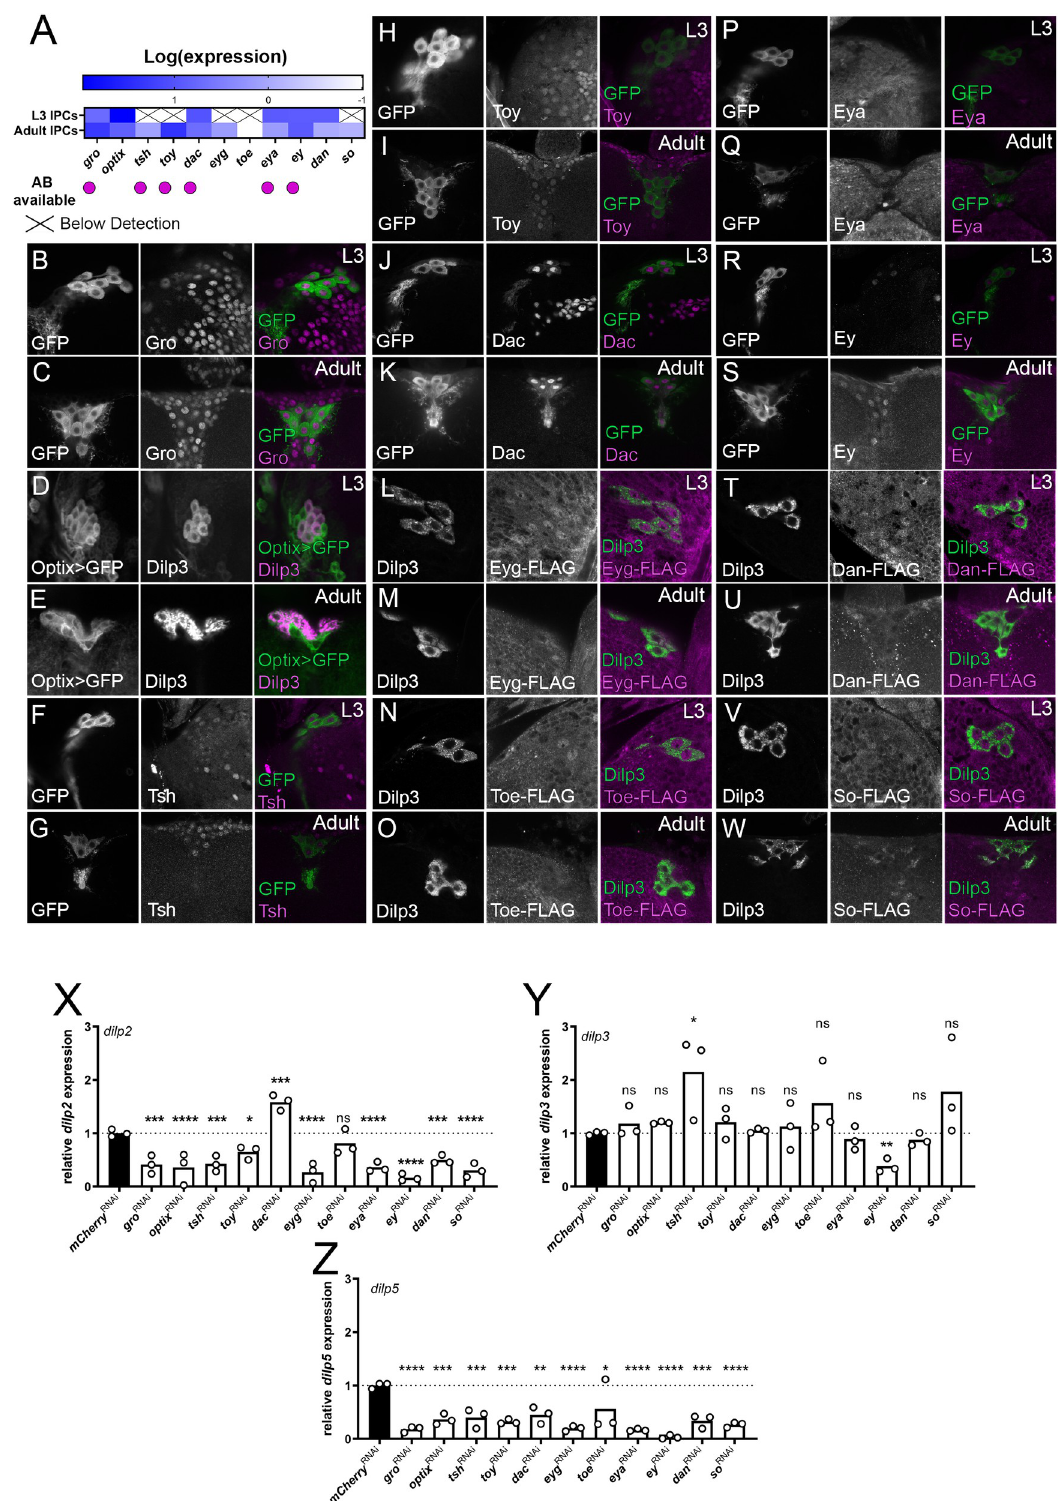
Fig 7. Most RDGN transcription factors are expressed in the IPCs and are required for normal adult dilp expression. (A). Additional RDGN transcription factors are expressed in larval and/or adult IPCs (Larval transcriptome data is taken from Cao et al., (2014) [39] while adult transcriptome data was generated for this study. (B-W) Gro, Tsh, Toy, Dac and Ey are readily detected in